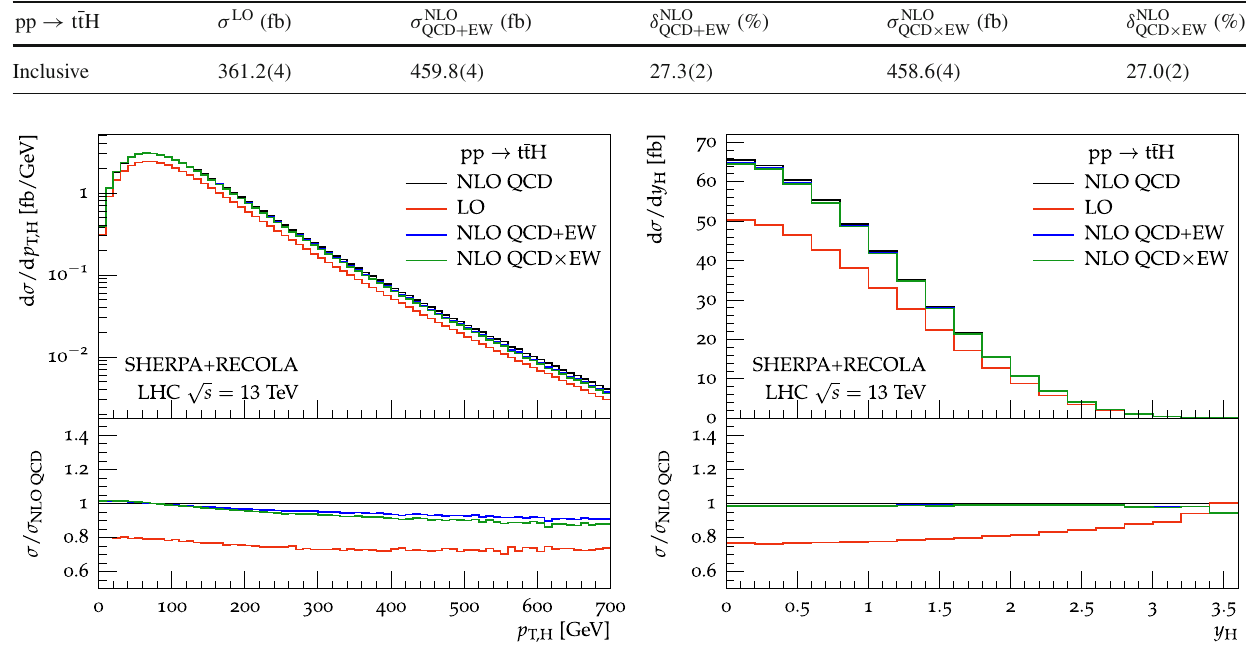
Fig. 15 Differential distributions at a centre-of-mass energy rapidity distribution of the Higgs boson ( right ). The lower panels show the ratios σ LO /σ NLO